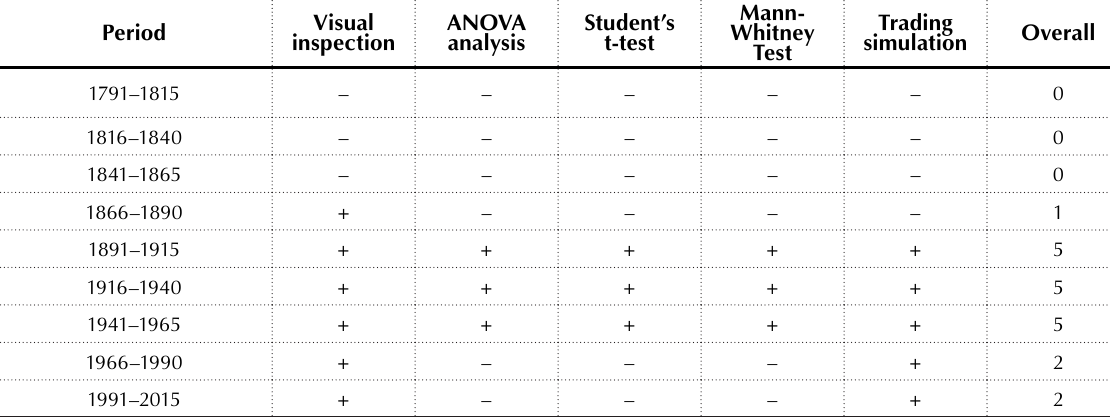
Table 2. Overall results for the January effect: case of the US stock market during